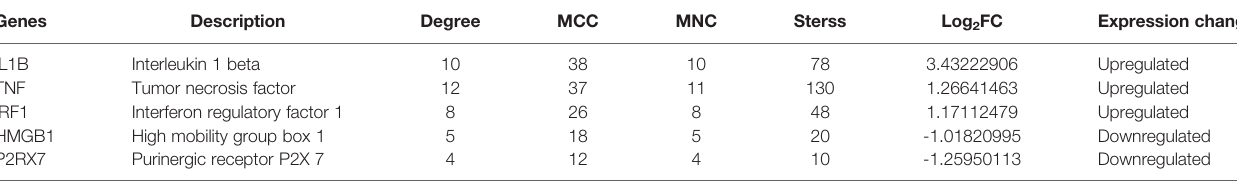
MCC, maximal clique centrality; MNC, maximum neighborhood